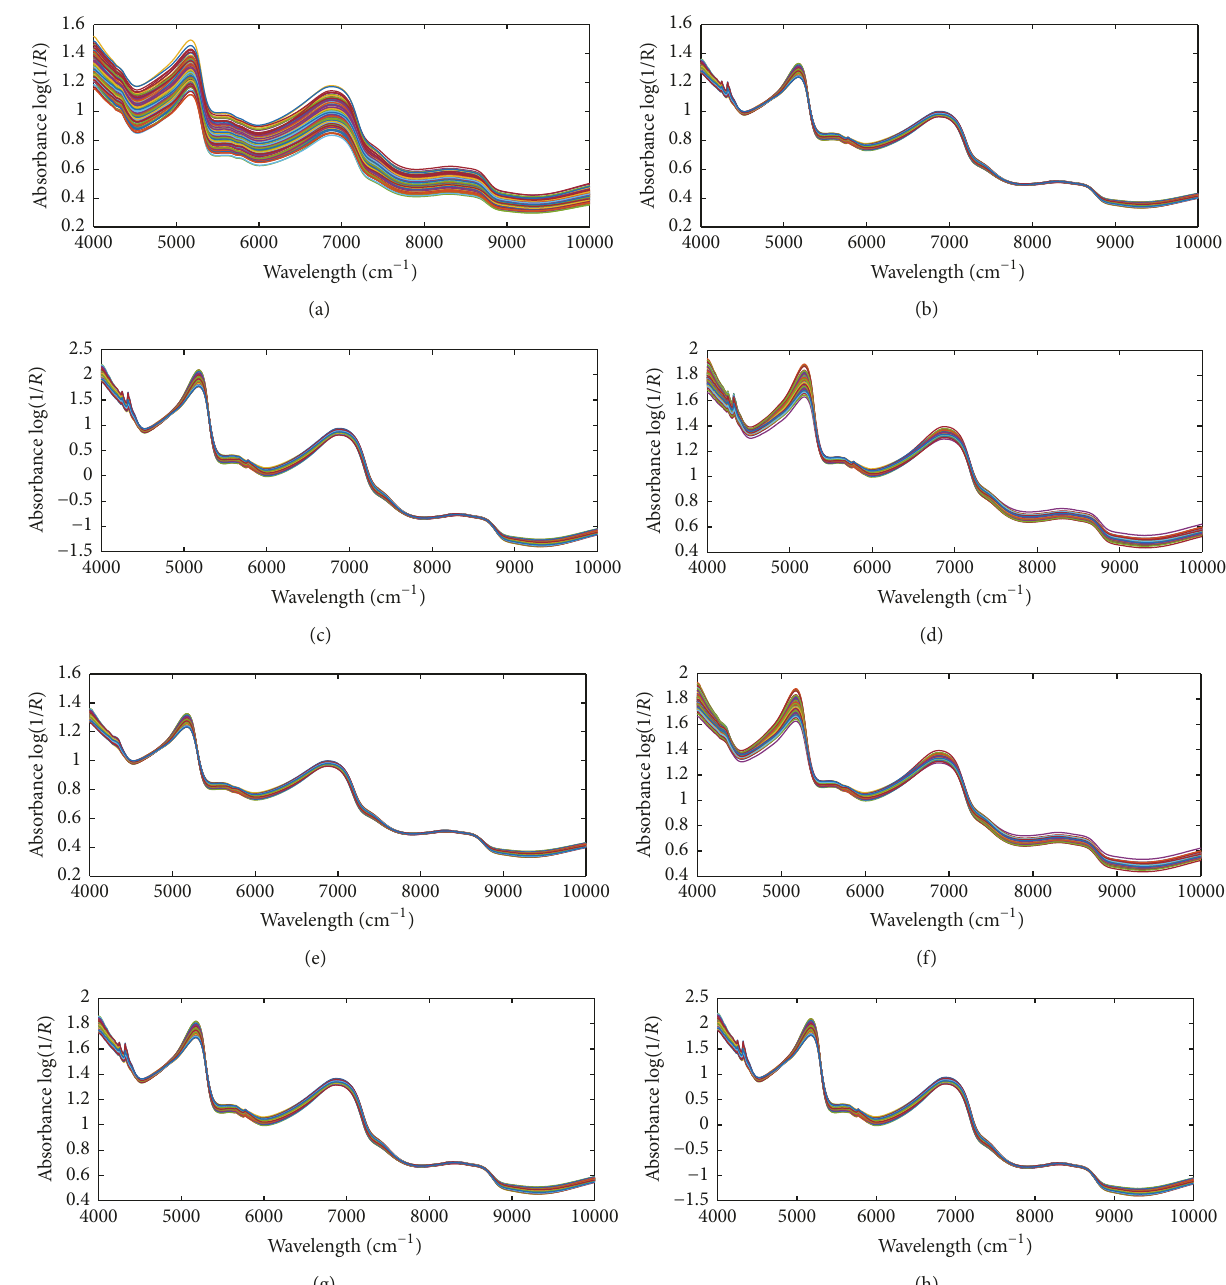
Figure 5: The preprocessed spectra by S-G smoothing (a), MSC (b), SNV (c), MeanN (d), combination of S-G smoothing and MSC (e), combination of S-G smoothing and MeanN (f), combination of MSC and MeanN (g), and combination of MSC and SNV